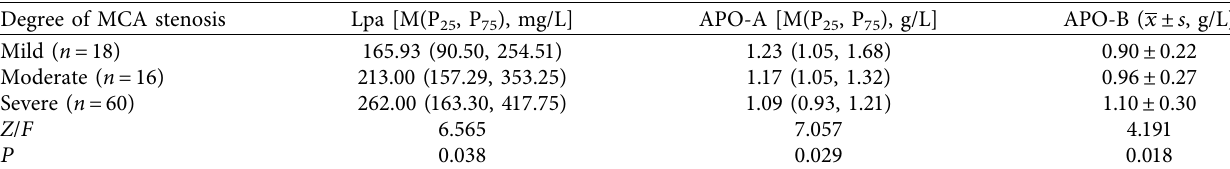
Table 5: Comparison of Lpa, APO-A, and APO-B in CIS patients with diferent degrees of MCA